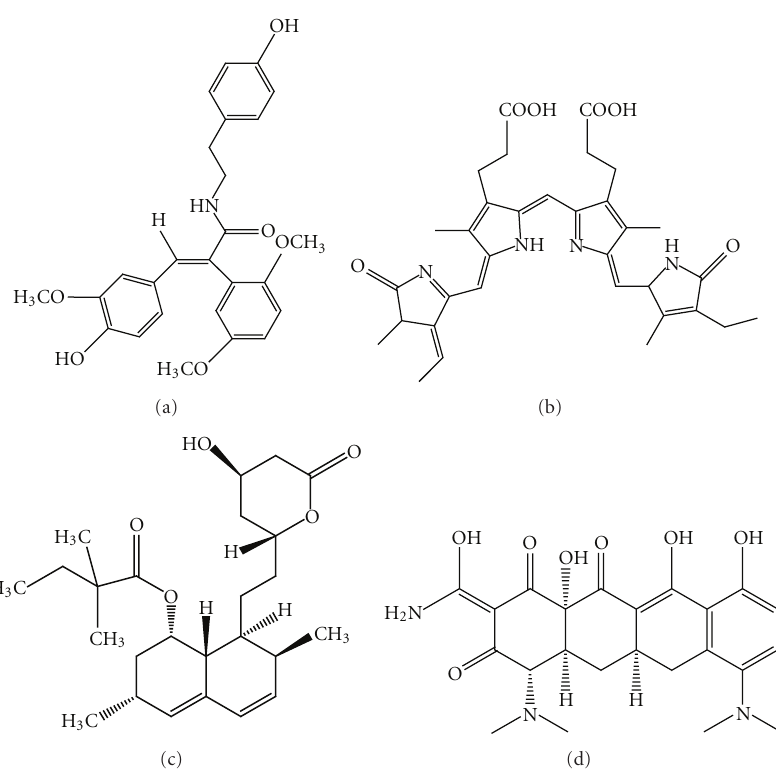
Figure 3: Chemical structure of FLZ (a), phycocyanobilin (b), simvastatin (c), and minocycline (d). oxidase activity in various human cell cultures at micromolar concentrations. PCB may thus have versatile potential for preserving the healthy function of the CNS in advanced old age patients su ff ering from neuroinflammatory diseases including